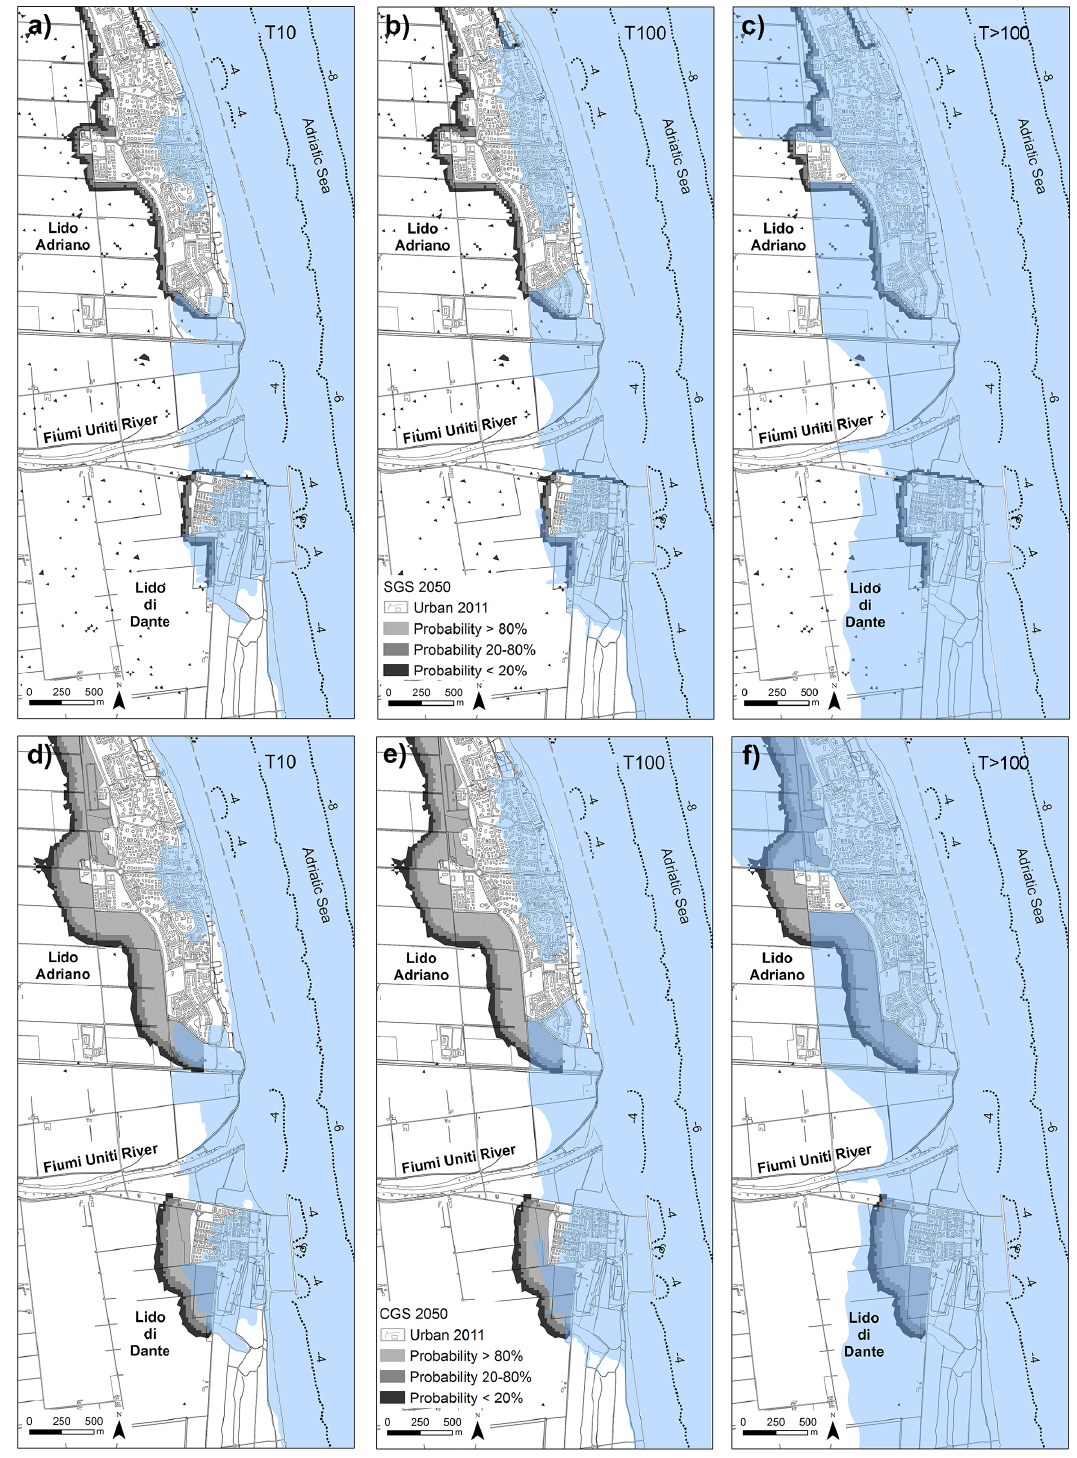
Figure 6. Overlay of coastal flood scenarios with the SGS (a–c) and the CGS (d–f) up to 2050: example of Lido Adriano–Lido di Dante,